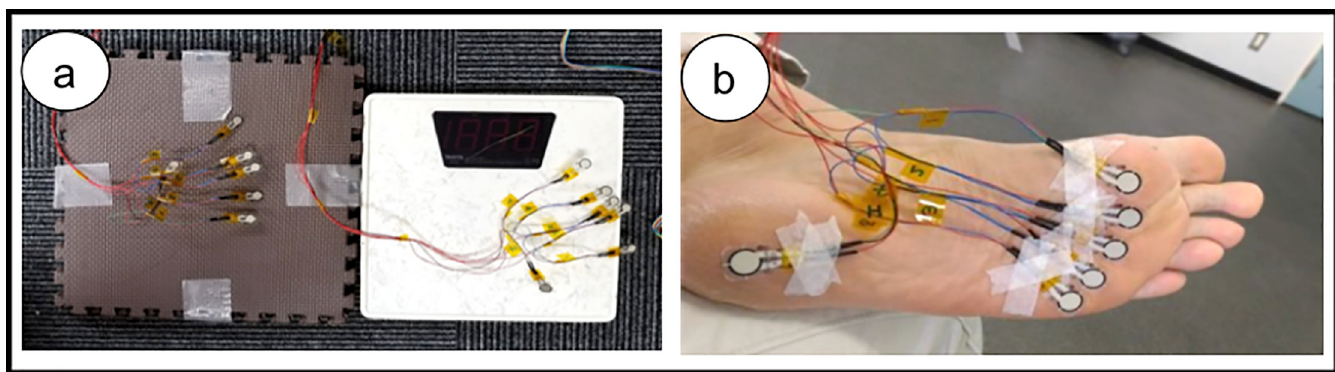
Fig 2. Force sensing device using force sensors. (a) Force sensors’ system with the 12 sensors and a weight scale; (b) shows the sensors stuck on the skin surface of the metatarsal heads after palpation.